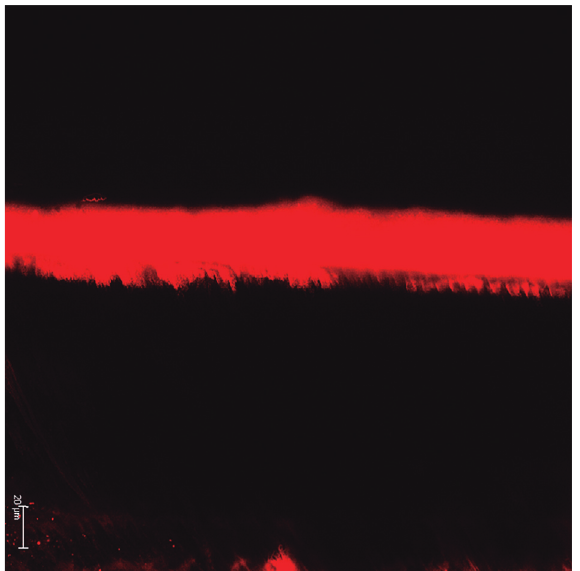
Figure 6a- Interface aspect of bonding system to enamel surface eroded by Light Coke (LC). Tags are thin and